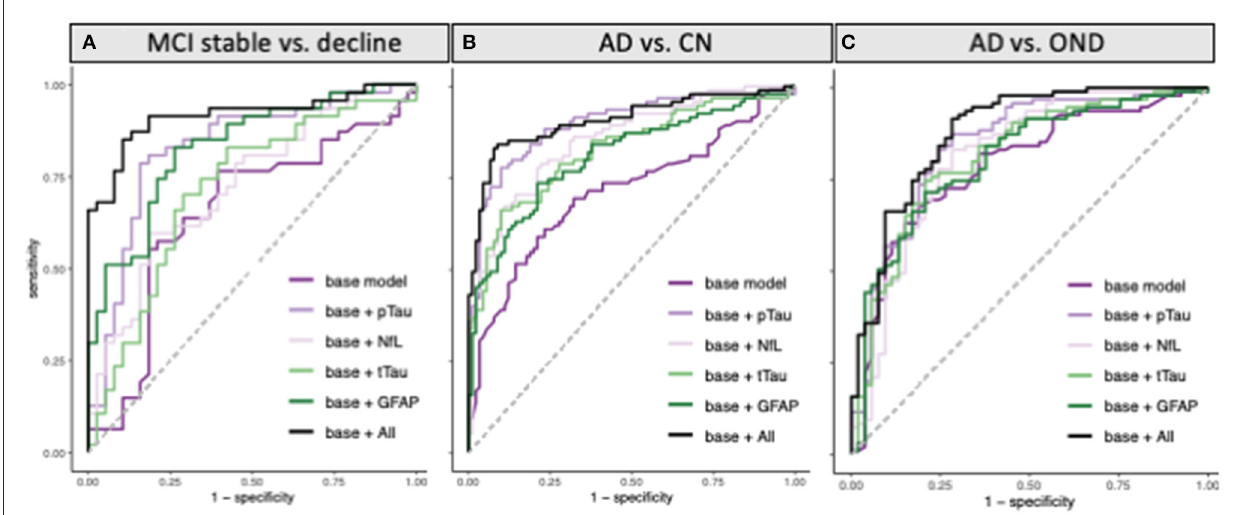
FIGURE4 ROC curves for classification of (A) MCI participants who progressed to a consensus diagnosis of AD dementia during 4 years of follow-up (MCI decline) vs. participants who remained stable during follow-up (MCI stable). (B) AD vs. cognitively normal controls (CN), and (C) AD vs. other neurodegenerative diseases (OND) using pTau181, tTau, NfL, and GFAP alone or all combined in addition to a base model containing age, sex, and APOE status.